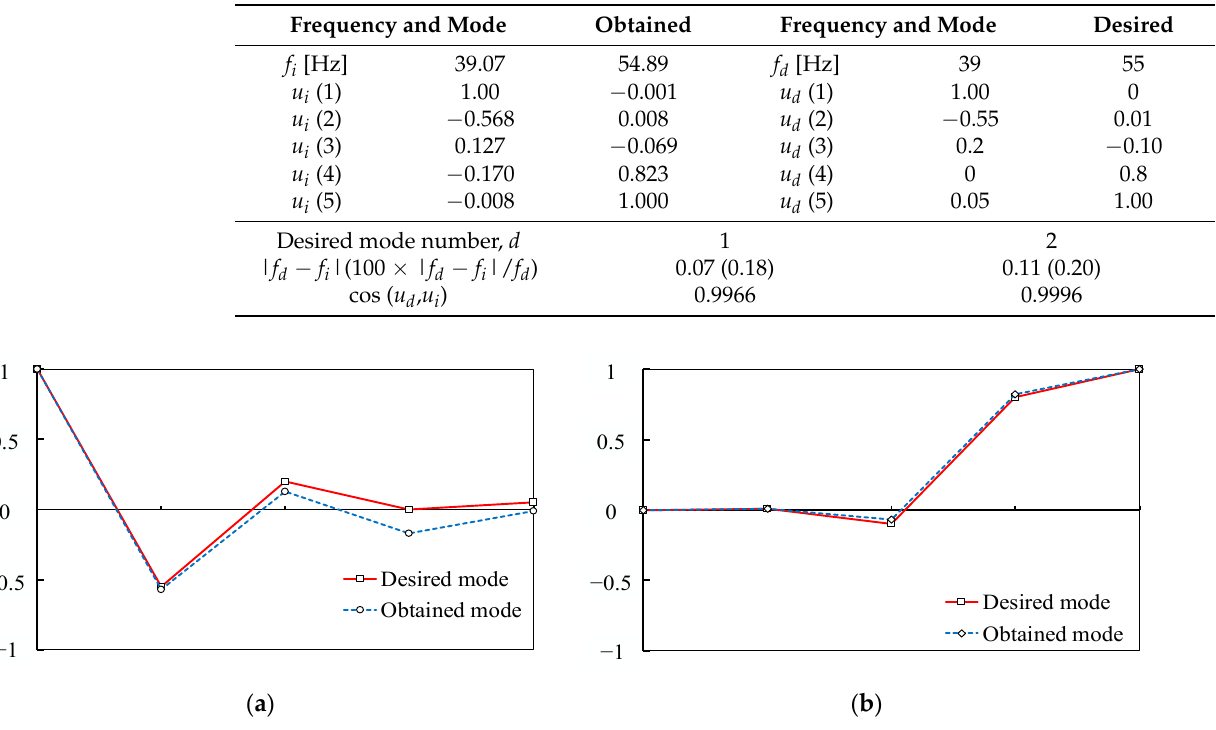
Figure 31. Comparison of desired and attained modes: ( a ) 39 Hz; ( b ) 55 Hz. Table 22. Comparison of natural frequencies and mode shapes.